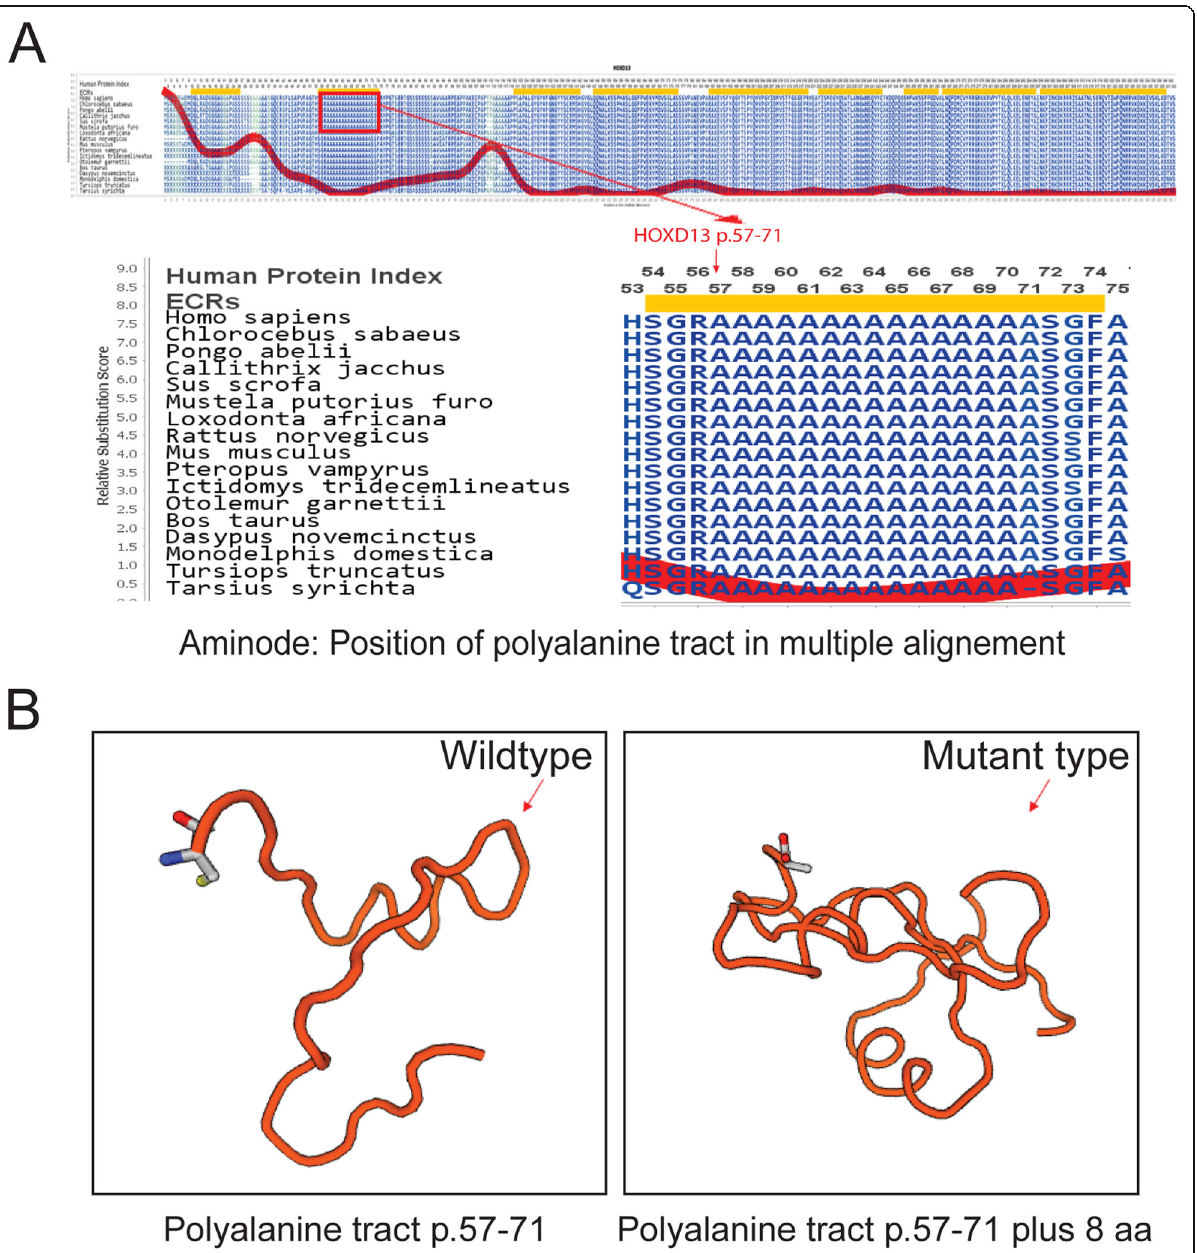
Fig. 6 Bioinformatic analysis of the HOXD13 duplication variation (c.183_206dup). a , Conservation analysis of HOXD13 using Aminode showed that polyalanine tract (p.57 – 71) of the HOXD13 protein is conserved among different species. b , Protein structure of HOXD13 wild type (p.57 – 71) and mutant type (p.57 – 71 plus 8 aa) showed that duplication variation locally affected the shape and size of HOXD13 protein, the images were created using SWISS-MODEL